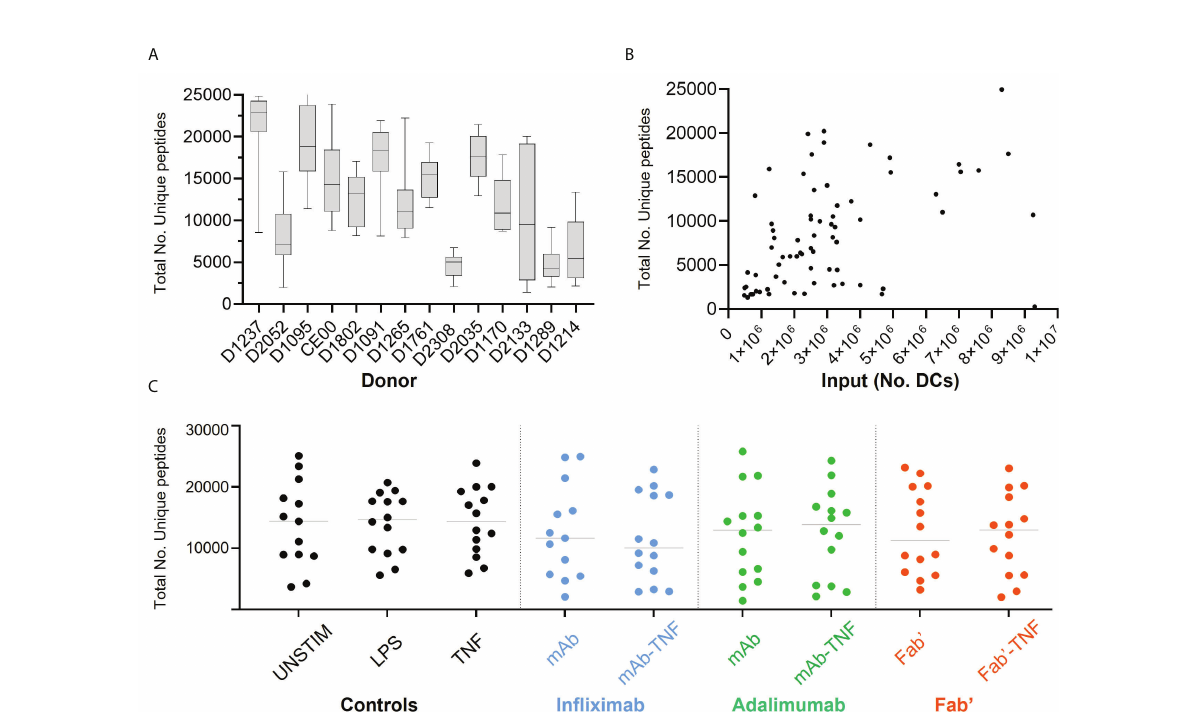
FIGURE 4 Total HLAII-associated peptides in monocytic-derived DCs. (A) Total number of unique peptides identi fi ed in the fourteen donors by HLAII immunopeptidomics, each box and whisker plot represent the mean and the SEM of independent data sets per donor. (B) Total number of unique peptides plotted against the number of DCs used as input, each point represents an experimental sample (n=124), where samples with >1x10 7 DCs were not included (2 sets). (C) Total number of unique peptides identi fi ed in the fourteen donors upon HLAII immunopeptidomics, where each set has the mean and data distribution from fourteen donors per treatment condition corresponding to INFL (blue) ADAL (green) and Fab ’